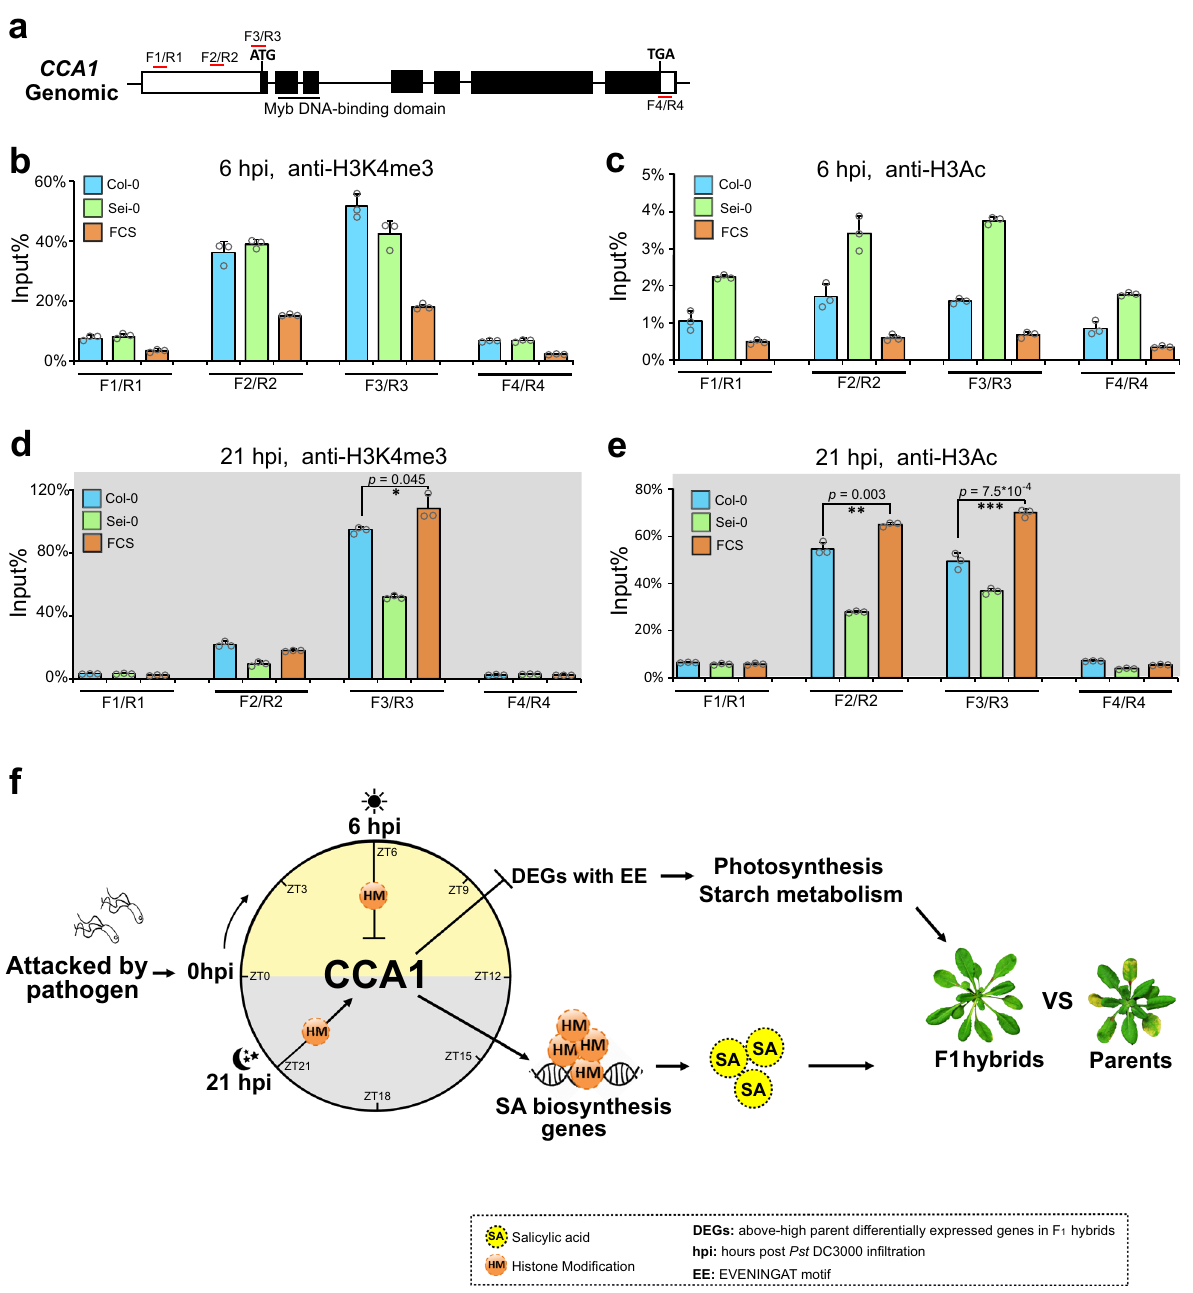
Fig. 5 Expression variations of CCA1 in hybrids correlated with its altered histone modi fi cation rhythms. a Regions of CCA1 used for the ChIP-qPCR assays. ChIP-qPCR analyses of four fragments (shown at a ) of CCA1 in the wild-type F 1 hybrids and parents using an anti-H3K4me3 antibody at 6 hpi ( b ) and 21 hpi ( d ). ChIP-qPCR analyses of four fragments (shown at a ) of CCA1 in the wild-type F 1 hybrids and parents using an anti-H3Ac antibody at 6 hpi ( c ) and 21 hpi ( e ). ChIP values in b – e were normalized to their respective DNA inputs. The results are representative of three biological replicates, with measurements taken from independent samples grown and processed at different times. Data are shown as the mean ± SD ( n = 3, n indicates biological replicates). f Working model of how CCA1 coordinates enhanced heterosis for defense and for biomass in hybrids under pathogen invasion. * p value < 0.05; ** p value < 0.01; and *** p value < 0.001 (two-tailed Student ’ s t